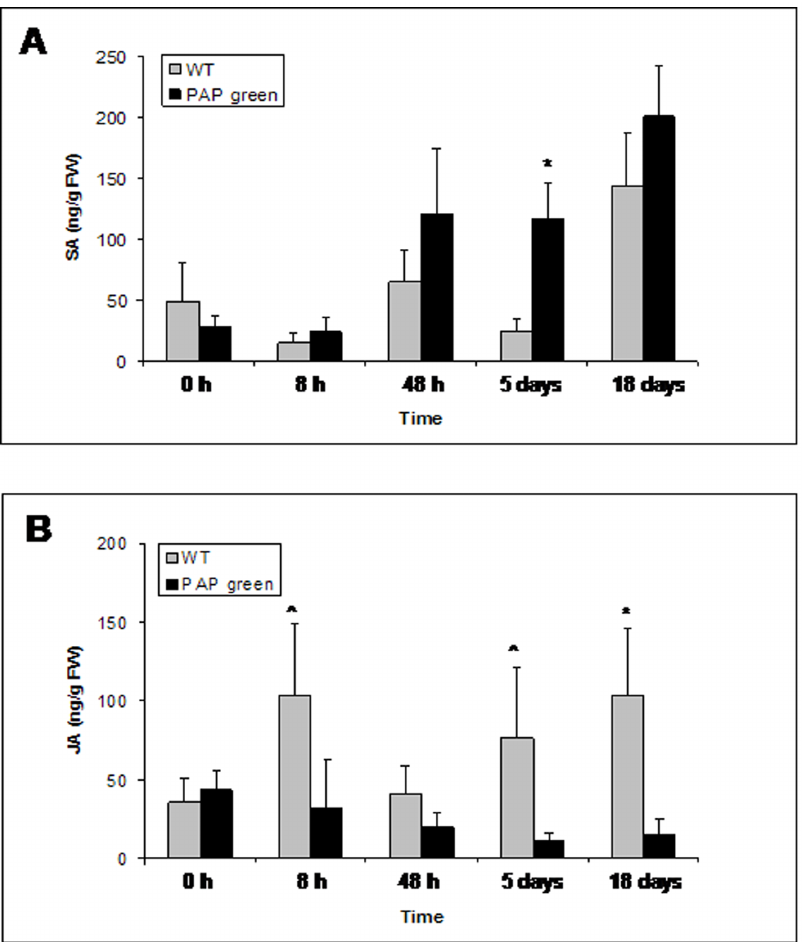
Figure 4. Chemical analyses of SA and JA hormone levels. A) SA levels in WT (gray bars) and PAP green (black bars) plants before and after 8 h, 48 h, 5 days and 18 days of B. tabaci infestation. B) JA levels in WT (gray bars) and PAP green (black bars) plants during the same infestation periods. Values are means of ng SA or JA per g fresh weight (FW) 6 standard error. Asterisks indicate significant differences ( P # 0.05) between WT and PAP green plants in each time point. The hat symbol indicates nearly significant differences ( P